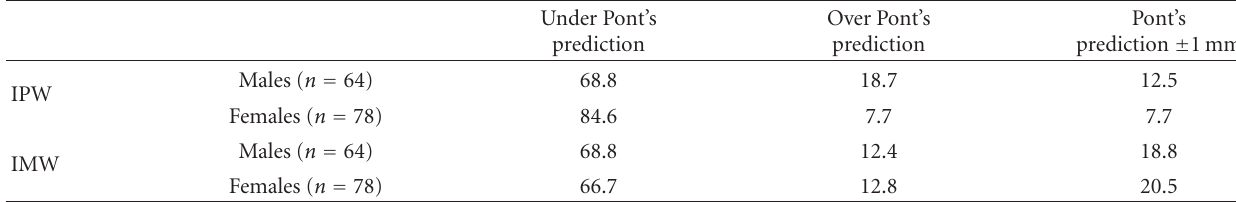
Table 3: Percentage of individuals having an observed arch width values under, over, and ± 1 mm around Pont’s